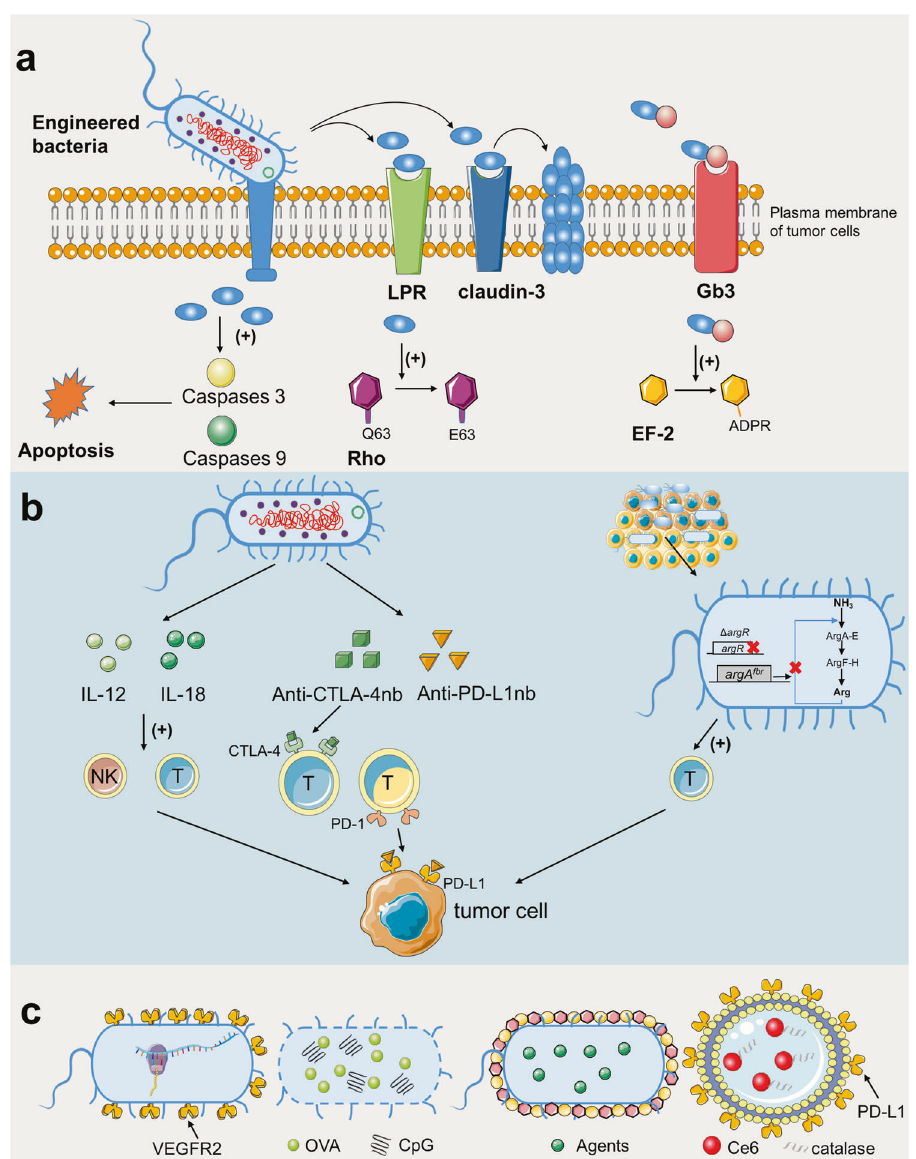
Fig. 3 Engineered bacteria for cancer therapy. Current strategies can be divided into three types: a expression of toxic proteins to directly kill cancer cells, b immunotherapeutics, and c therapeutic drug delivery vehicles. a Bacteria could utilize secretion systems such as T3SS and T6SS to directly inject bacterial effector proteins into eukaryotic host cells, or secret effectors targeting receptors on cell surface. LRP laminin receptor precursor protein, EF-2 elongation factor 2. b Engineered bacteria could express cytokines or other chemical molecules to induce proper immune cells. IL-12 Interleukin 12, CTLA-4 cytotoxic T-lymphocyte-associated antigen-4, PD-1 programmed death-1, PD-L1 programmed cell death protein-ligand 1, nb nanobody. c Bacteria-based vaccine or drug delivery systems. VEGFR2 vascular endothelial growth factor 2, OVA